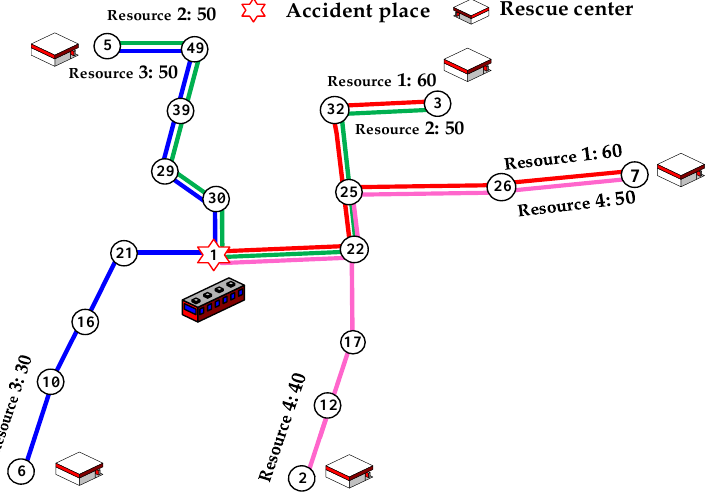
Figure 9. The rescue resource scheduling of Scheme 2.